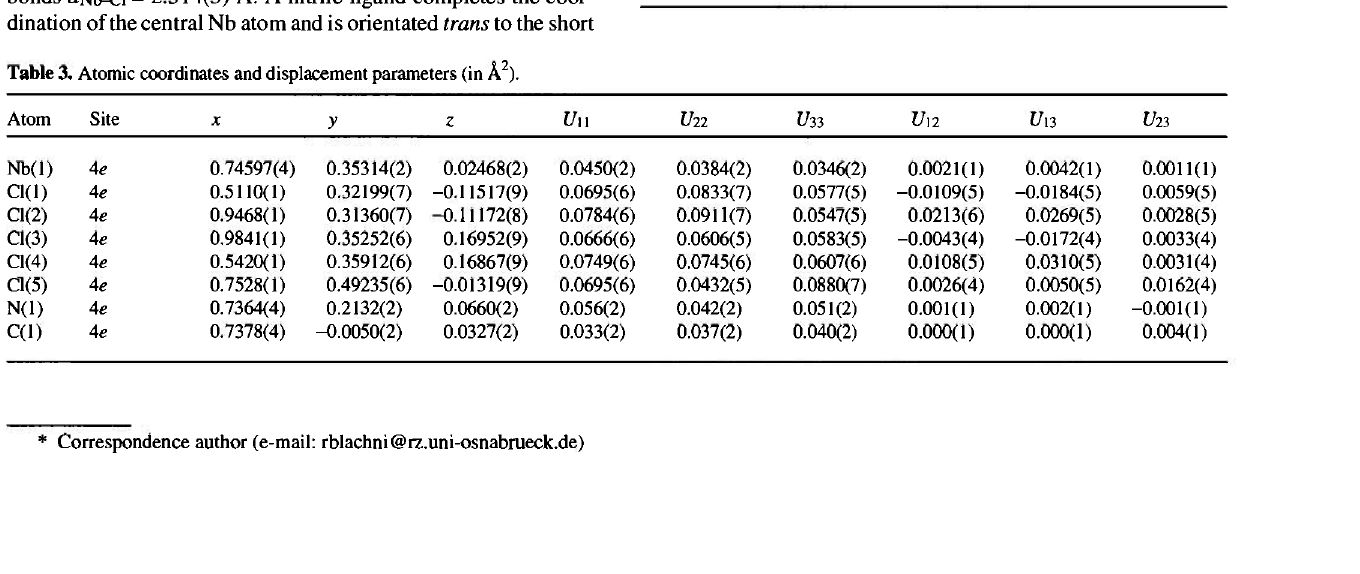
Table 2. Atomic coordinates and displacement parameters (in Ä 2